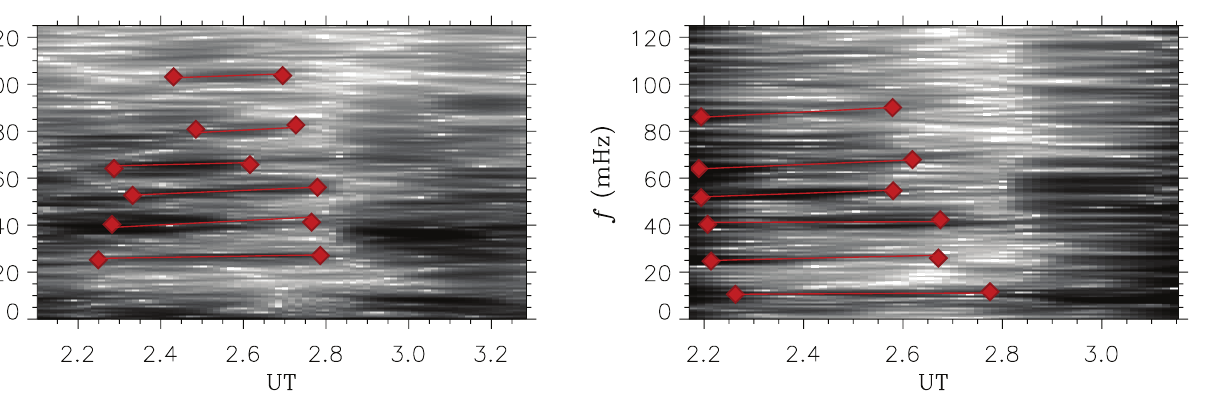
Fig. 4. Like Fig. 3, but using the power spectrum of the radial component of the electric